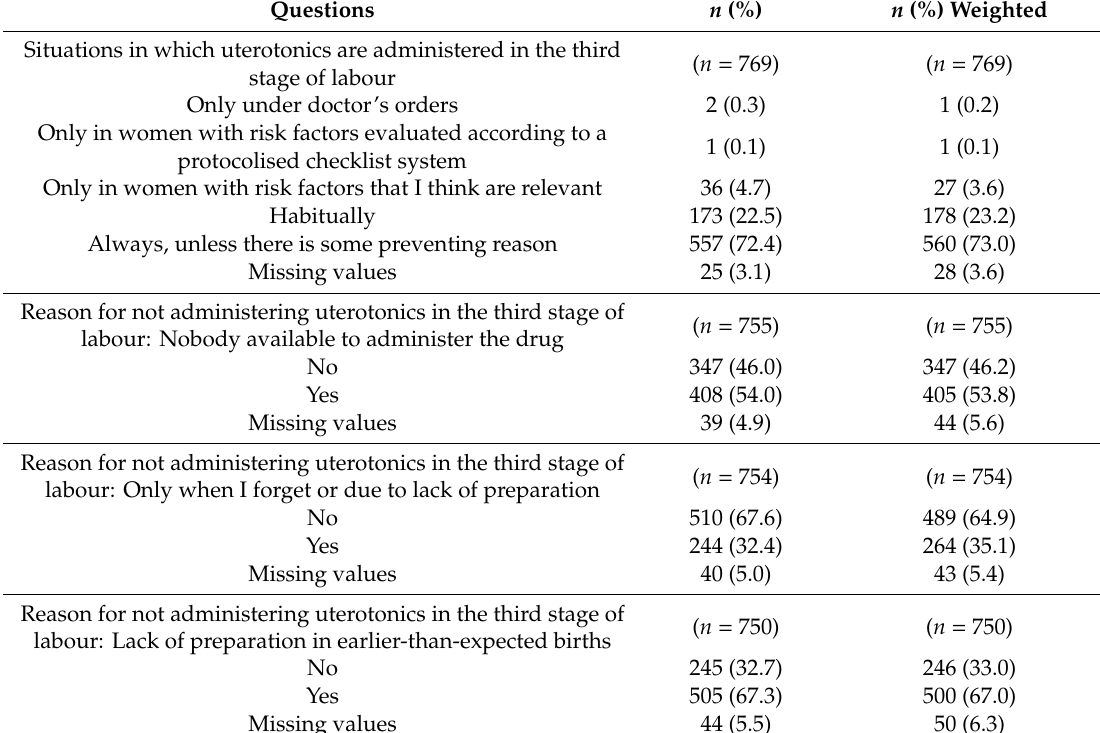
Table 3. Clinical practices during the third stage of labour, only for professionals that used uterotonics in the third stage of labour ( n =